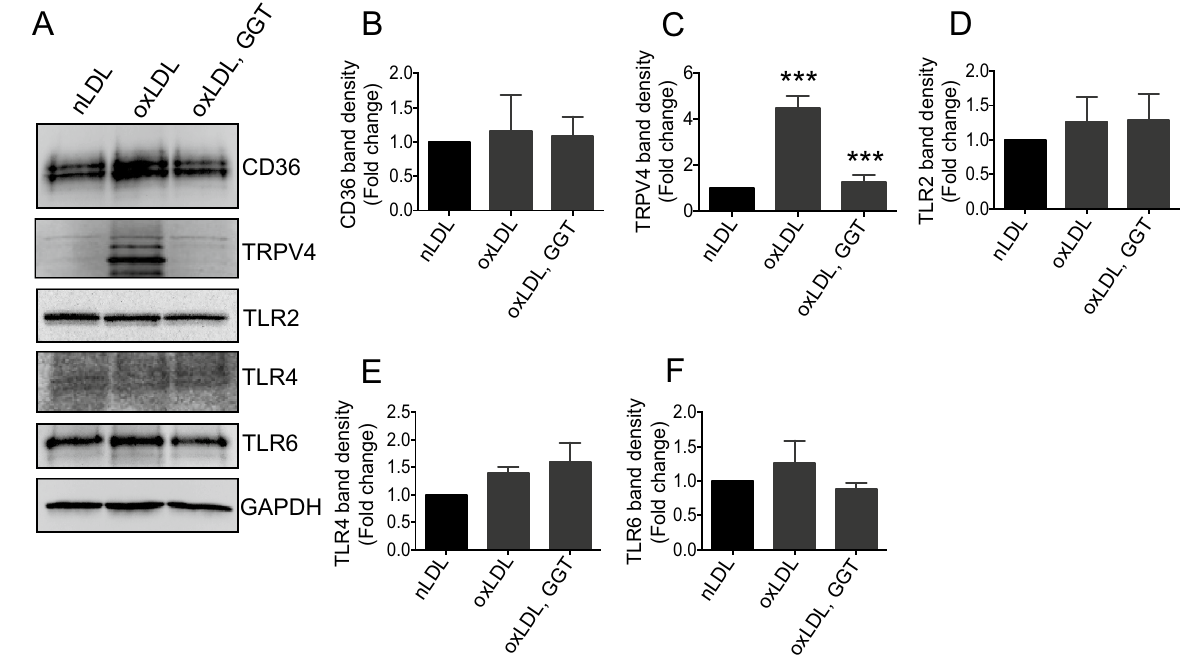
Figure 4. Ginkgetin blocks oxLDL-induced upregulation of TRPV4 proteins in macrophages. Whole cell lysates were prepared from macrophages pretreated with vehicle or 10 µM ginkgetin for 3 h followed by overnight incubation with 50 µg/mL of oxLDL or nLDL. Representative immunoblots ( A ) show total protein expression of CD36, TRPV4, TLR2, TLR4, TLR6, and GAPDH in ginkgetin-treated and untreated cells in the presence of oxLDL or nLDL. Quantitative analysis of CD36 ( B ), TRPV4 ( C ), TLR2 ( D ), TLR4 ( E ), and TLR6 ( F ) proteins shown in ( A ). Student’s t -test, *** p < 0.001, Data represent ±